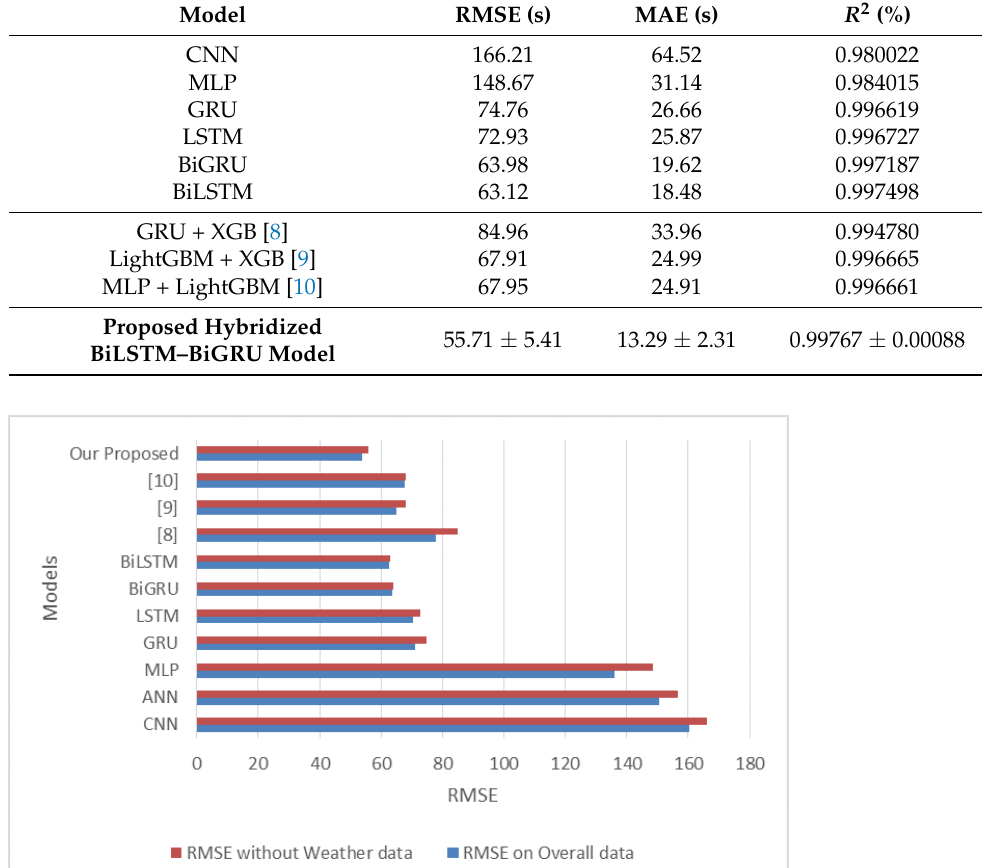
Table 5. The results from the experiment on the impact of weather conditions on TTP.